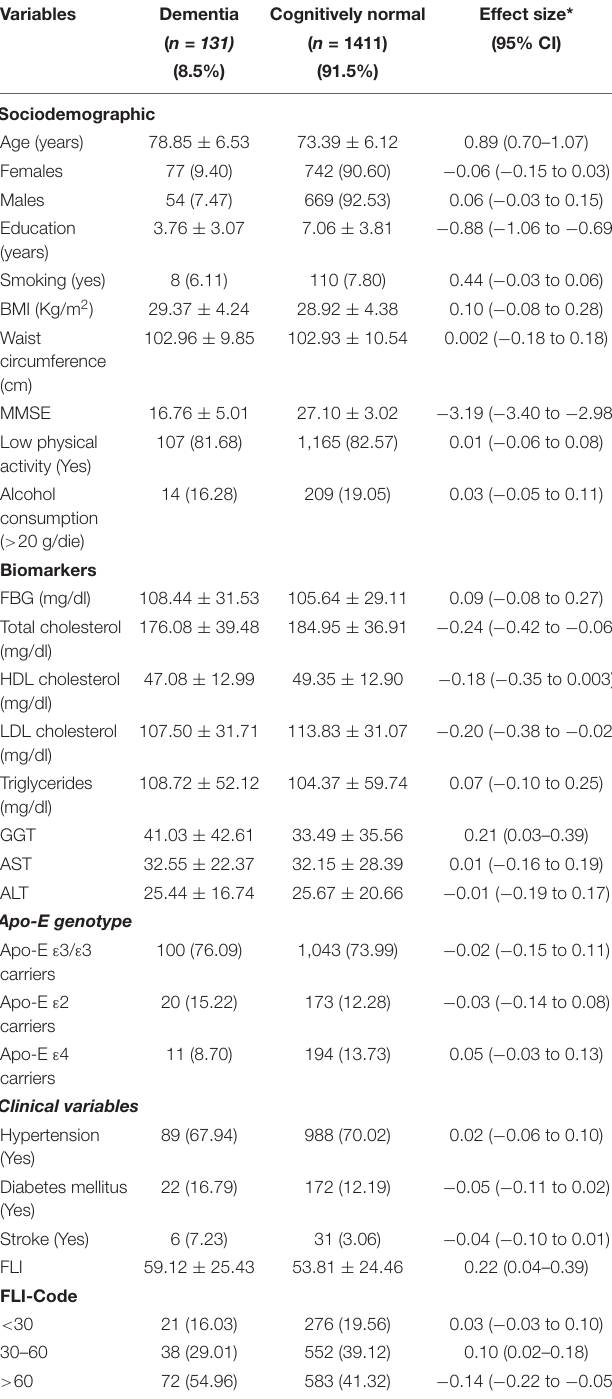
TABLE 1 | Sociodemographic and clinical variables in cognitively normal subjects and patients with